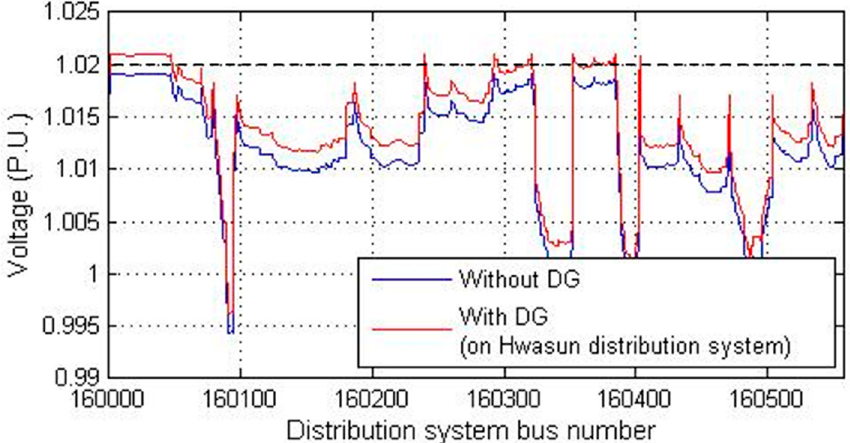
Figure 6. Voltage profile of the Hwasun distribution system.